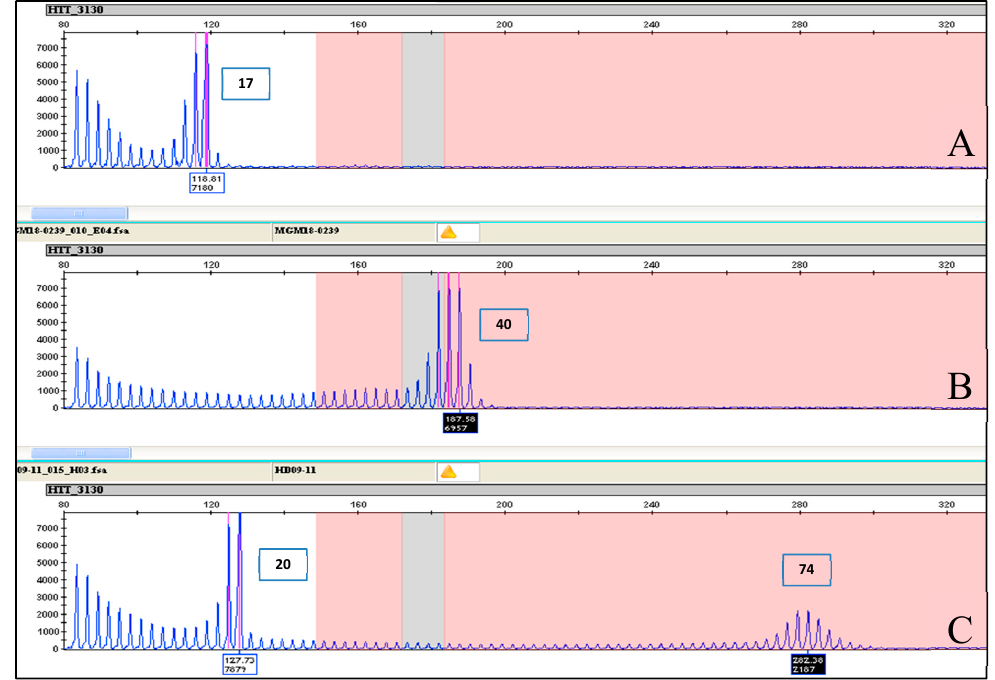
Figure 5. Difference between homo- and heterozygous alleles electropherogram results. ( A ) Electropherogram results of sample MGM17-1760 showing a homozygous allele of 17 CAG repeats. ( B ) Electropherogram results of sample MGM18-0239 showing a homozygous allele of 40 CAG repeats. ( C ) Electropherogram results of sample HD09-11 showing a heterozygous allele of 20 CAG repeats and an expanded allele of 74 CAG repeats. Note the continuous stuttering after the prominent peak at 20 CAG repeats to peak at 74 CAG repeat in the close-up view, which is an indication of the presence of an expanded allele .